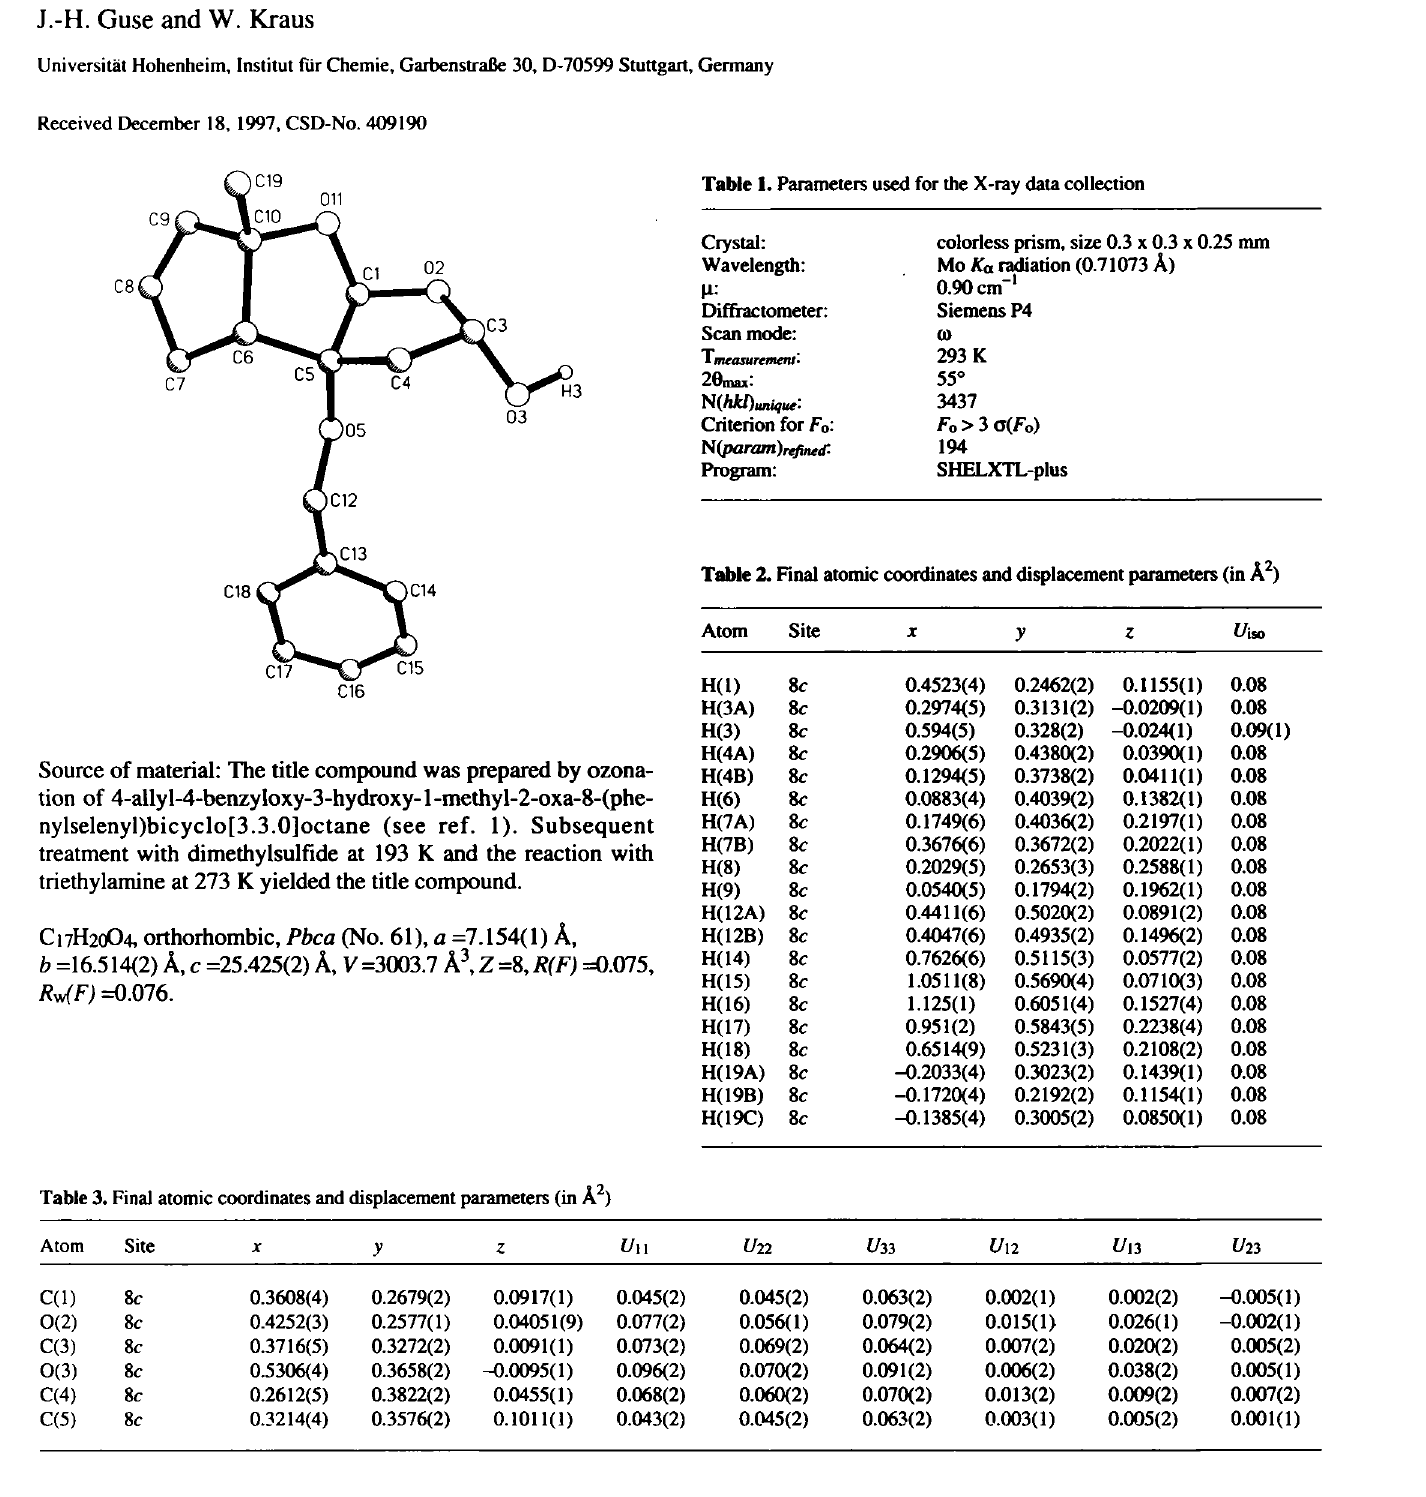
Table 1. Parameters used for the X-ray data collection